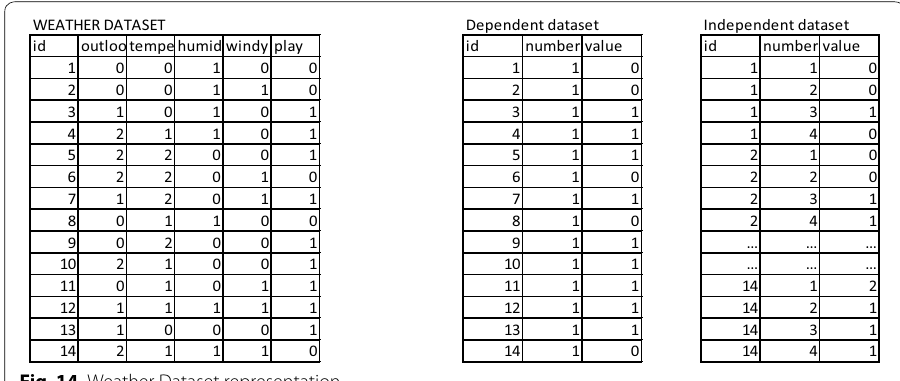
Fig. 14 Weather Dataset